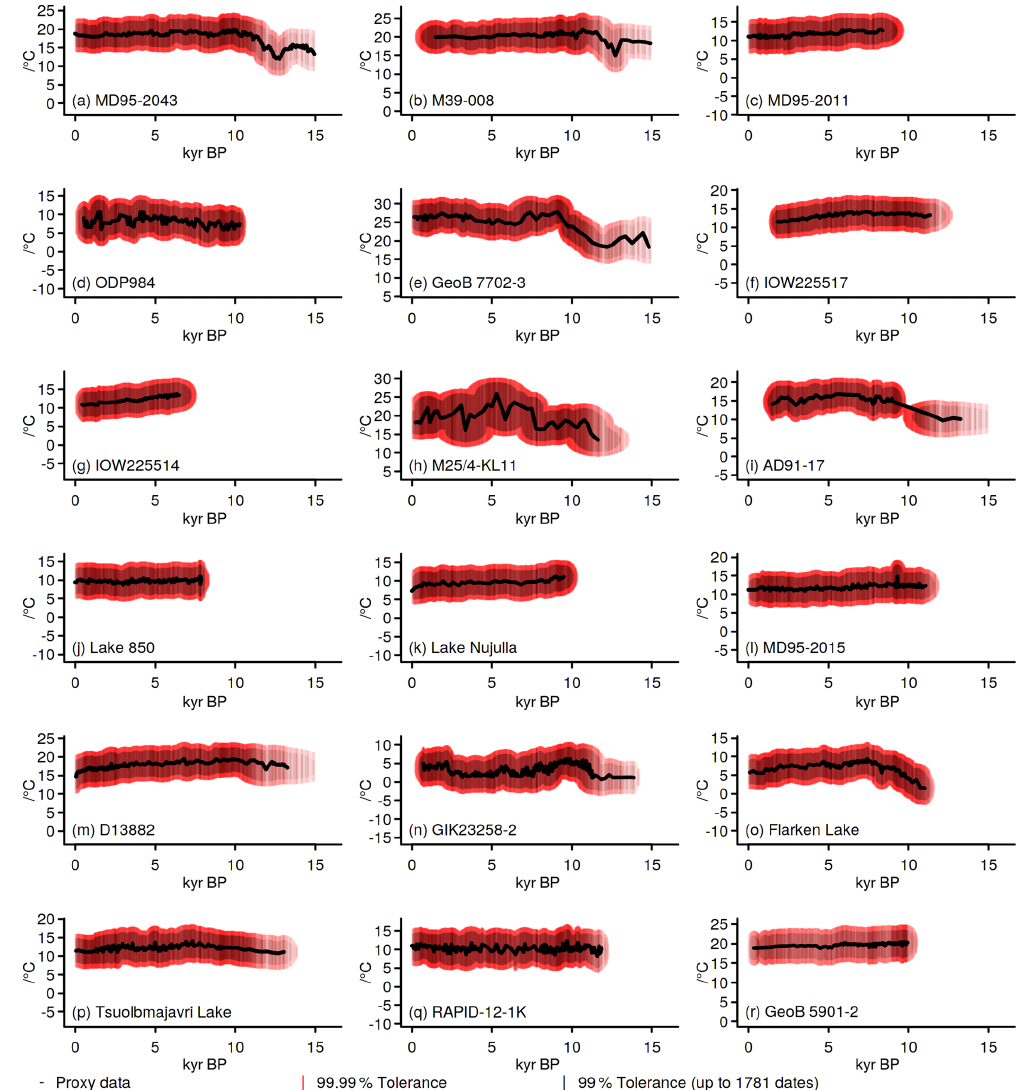
Figure 8. Proxy data and assumed uncertainties for all proxy-record locations in our analogue search under two different tolerance